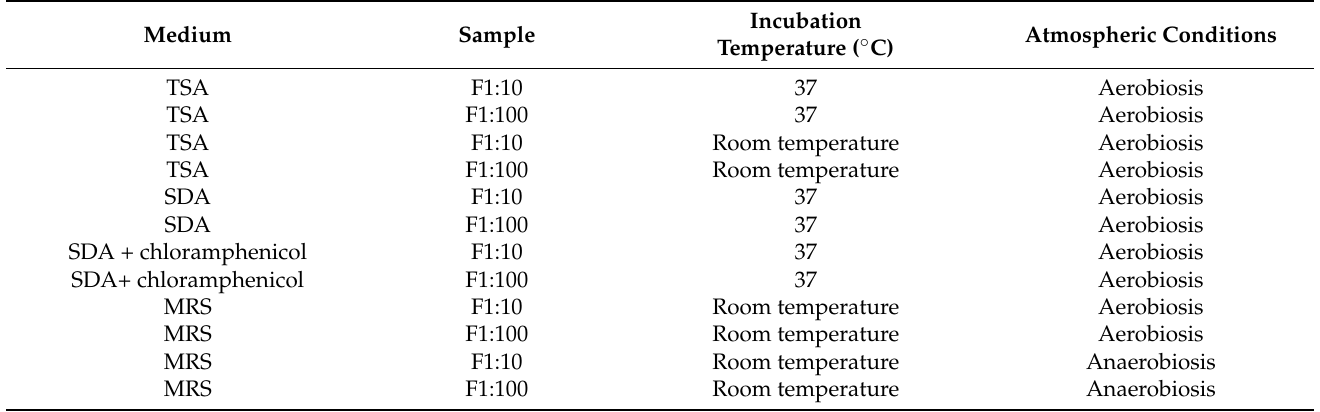
Table 1. Incubation conditions of the plates inoculated with wine lees samples